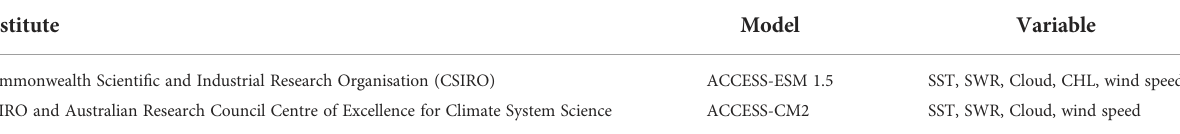
TABLE 1 CMIP6 models and output used in this